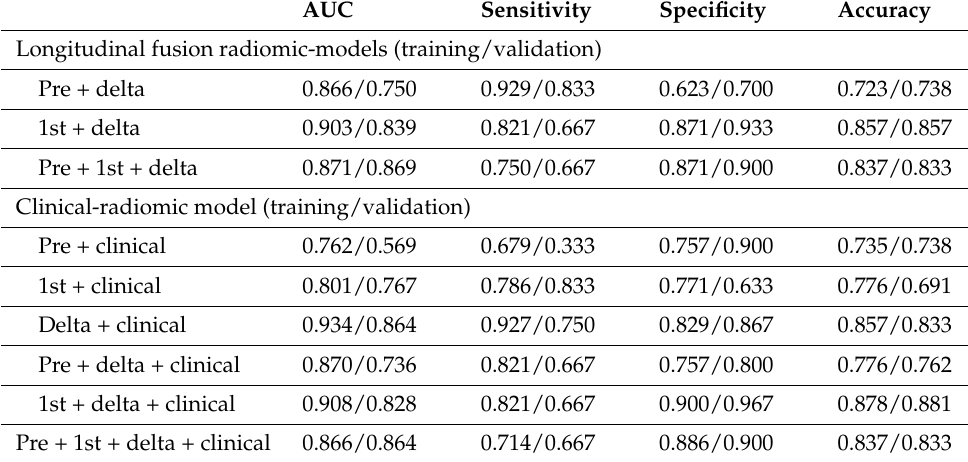
Table 3. Predictive performance of the longitudinal fusion radiomic models and clinical-radiomics models based on the early phase. AUC Sensitivity Specificity Accuracy Longitudinal fusion radiomic-models